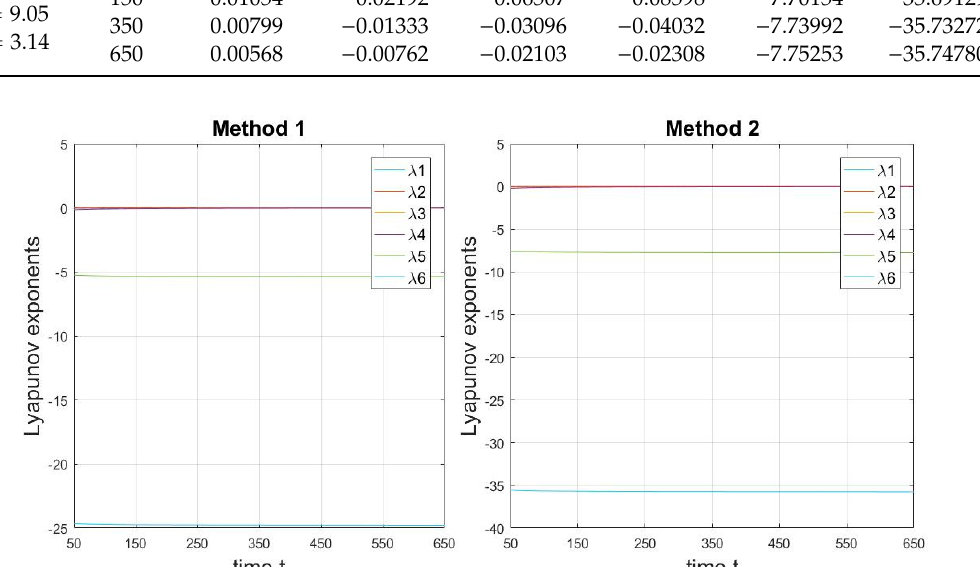
Figure 13. Time history of Lyapunov exponents starting at (cid:1872) = 50 for (cid:1829) = 0.05 , (cid:1863) = 40 , (cid:2033) = 2.84 .